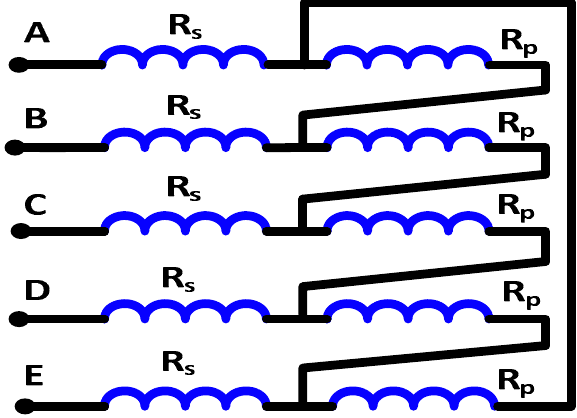
Figure 1. Combined star–pentagon winding for one phase belt (phase A).